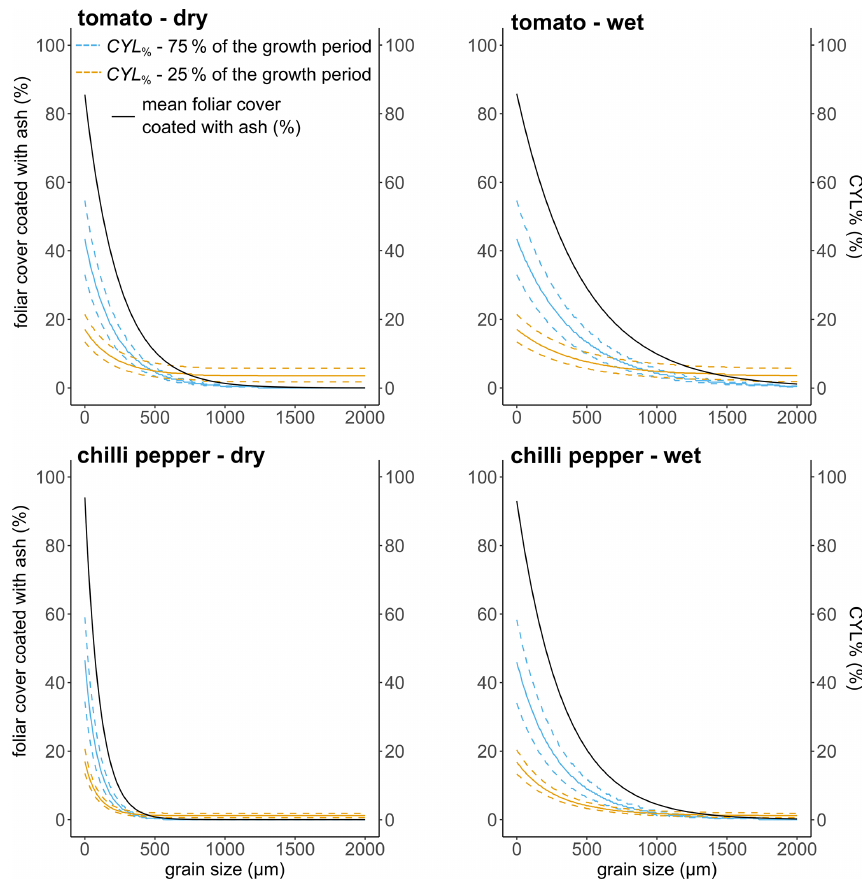
Figure 6. Potential crop yield loss (CYL % , first quartile, median, and third quartile) estimated for tomato and chilli pepper plants as a function of the ash grain size in dry and wet conditions at leaf